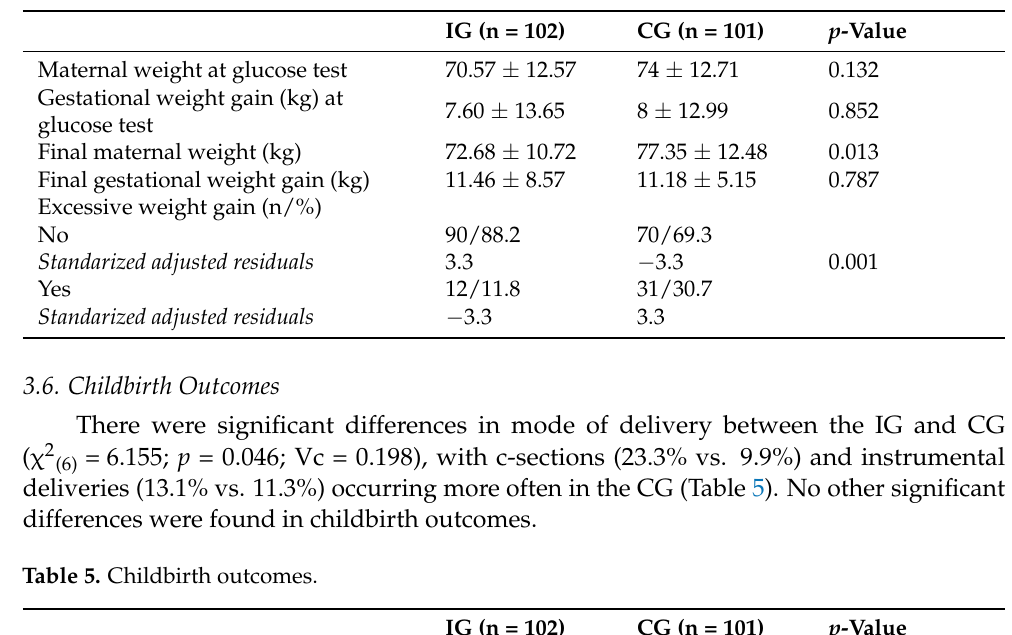
Table 4. Maternal outcomes.